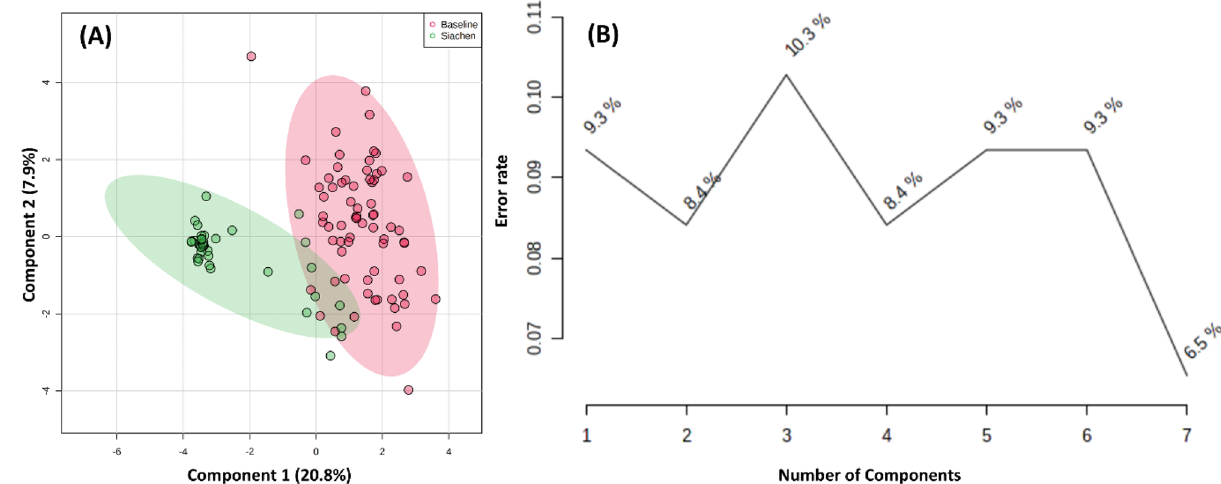
Figure 7. ( A ) sPLSDA score plots between selected PCs showing supervised clustering and separation between the sea-level control and Siachen groups, ( B ) Mean classification error rate for each sPLS-DA